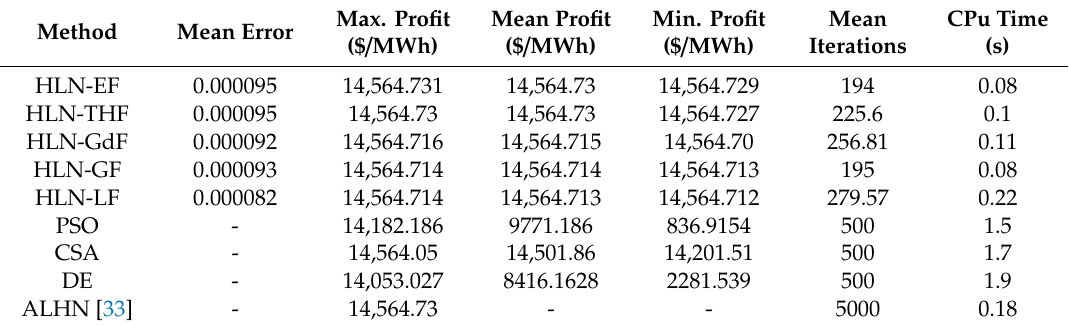
Table 3. Comparison of results obtained for the 10-unit system with the first revenue model.